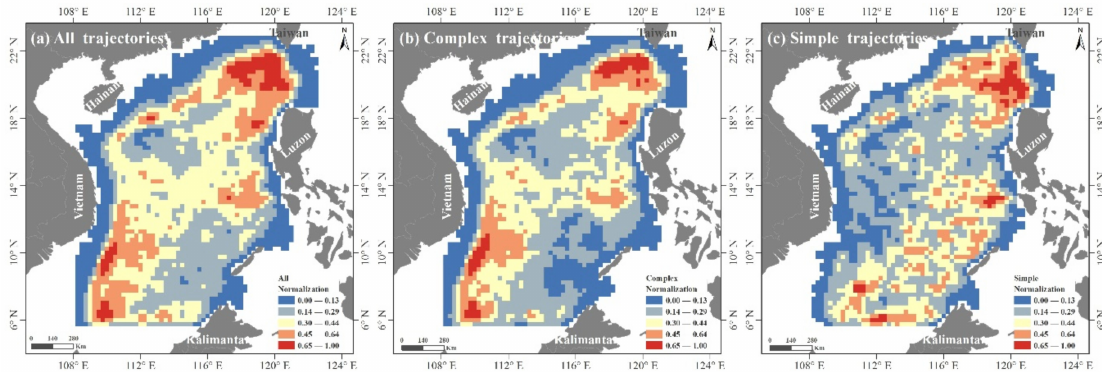
Figure 8. The grid-based trajectory density for all ( a ), complex ( b ), and simple ( c ) eddy